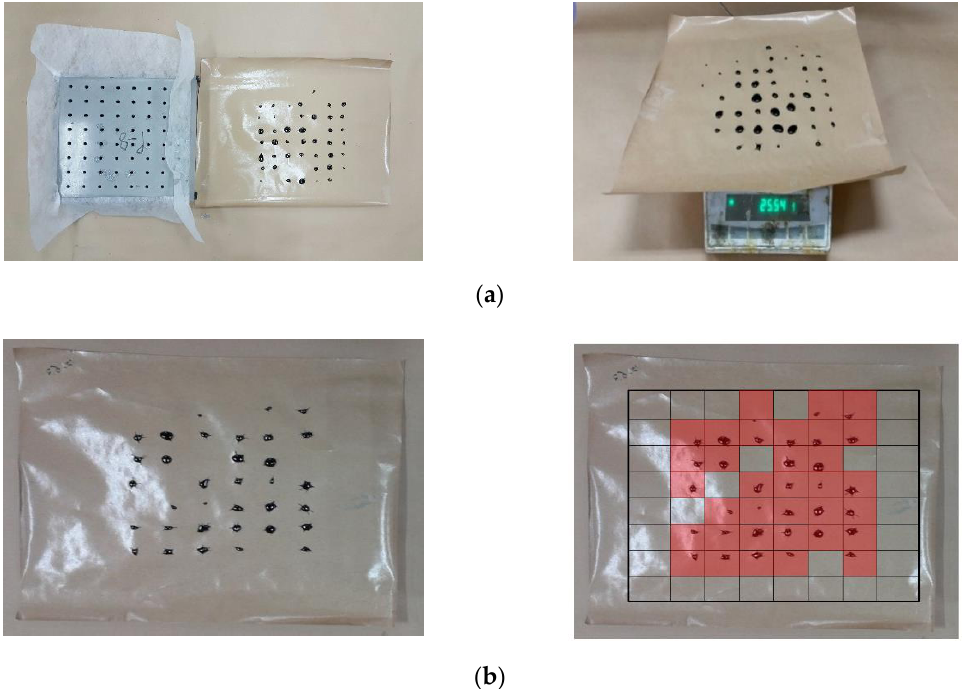
Figure 6. Oil Leakage observation and record; ( a ) oil leak collecting and mass measurement, ( b ) leaked surface area calculation illustrated.